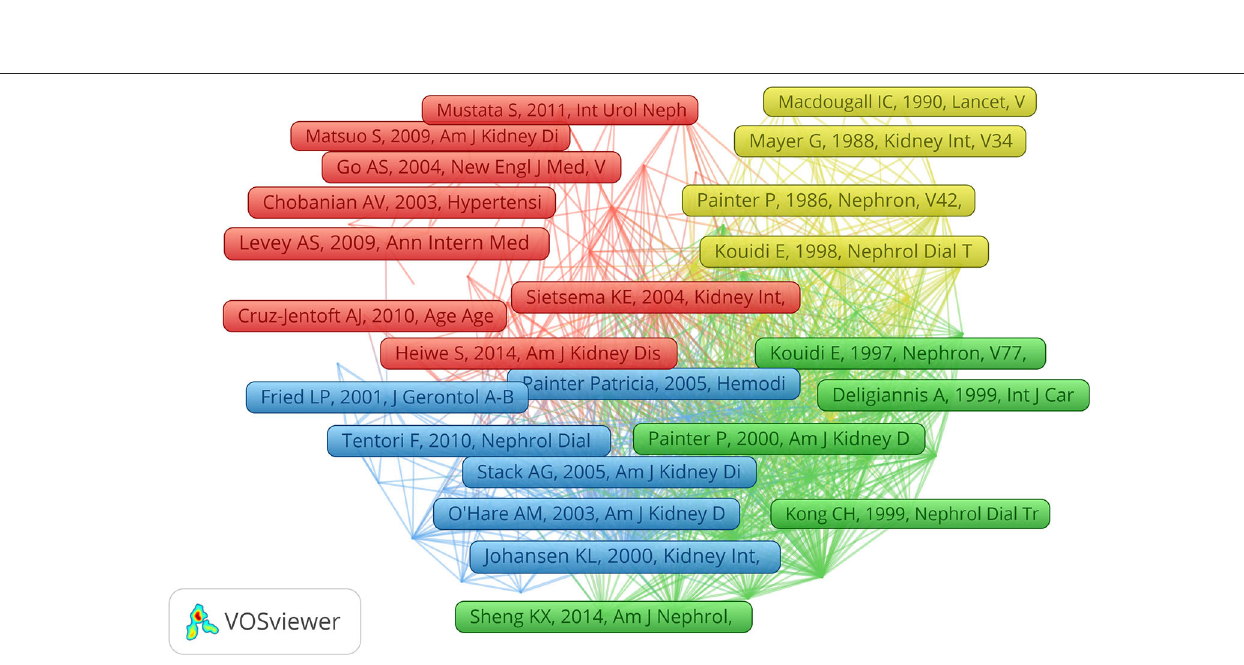
Frontiers in Medicine |